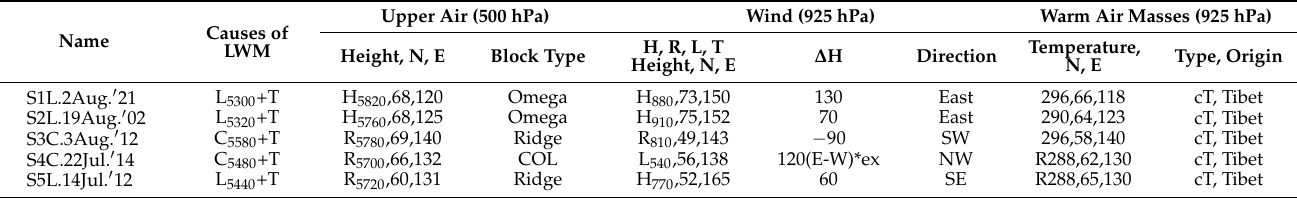
Table 3. Fire weather conditions of top five active fire periods in